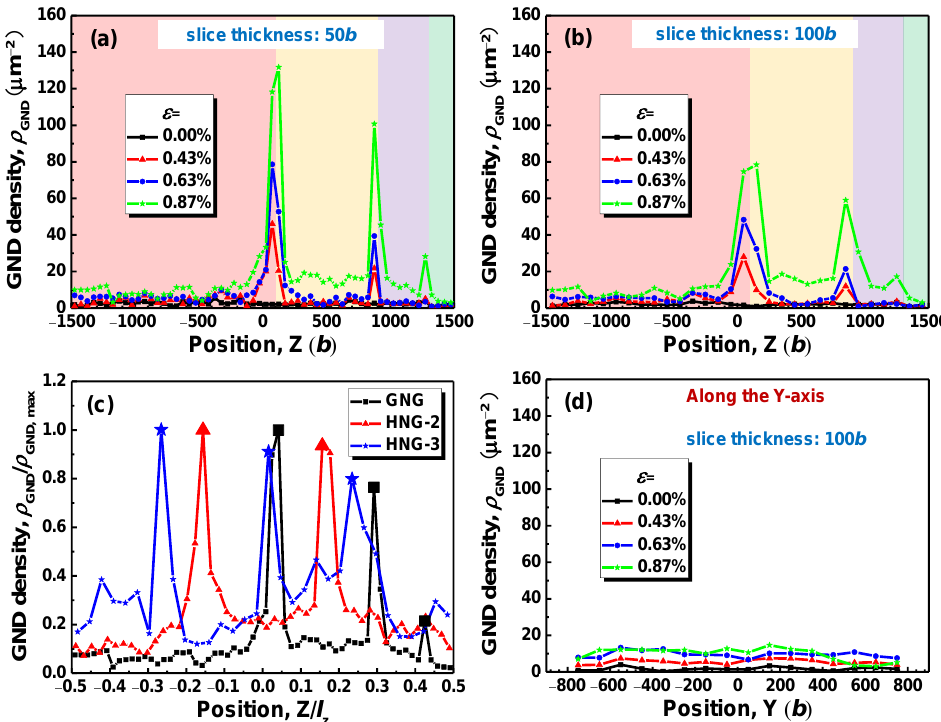
Figure 5. GND density along the Z -axis at four different applied strains for the GNG sample when the thicknesses of the divided slice are ( a ) 50 b and ( b ) 100 b . ( c ) Normalized GND density ρ GND / ρ GND,max at ε = 0.87% versus normalized position Z/ l z for GNG, HNG-2 and HNG-3 samples. ρ GND,max is the maximum value of the GND density of all slices in each sample, l z is the width of the sample in the Z -direction. The large symbols at the peaks indicate the values of ρ GND / ρ GND,max at the interfaces. The thickness of the divided slice in ( c ) is 50 b . ( d ) GND density along the Y -axis at four different applied strains for the GNG sample, the thickness of the divided slice is 100 b